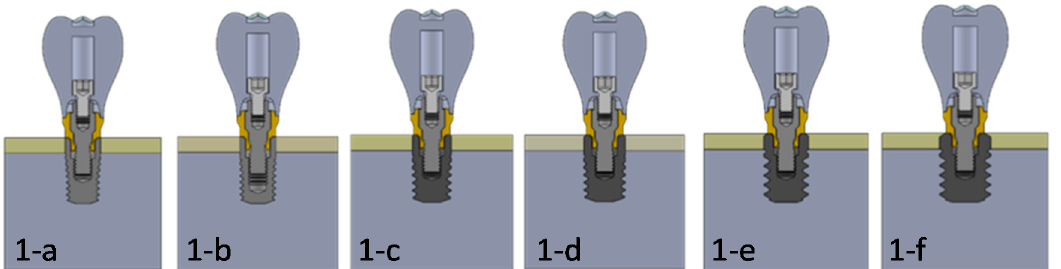
Figure 1. ( 1-a ). 3D model with an Ø3.3 implant in axial position and Type III bone. ( 1-b ). 3D model with an Ø3.5 implant in axial position and Type III bone. ( 1-c ). 3D model with an Ø3.75 implant in axial position and Type III bone. ( 1-d ). 3D model with Ø4 implant in axial position and Type III bone. ( 1-e ). 3D model with an Ø4.25 implant in axial position and Type III bone. ( 1-f ). 3D model with Ø4.75 implant in axial position and Type III bone.